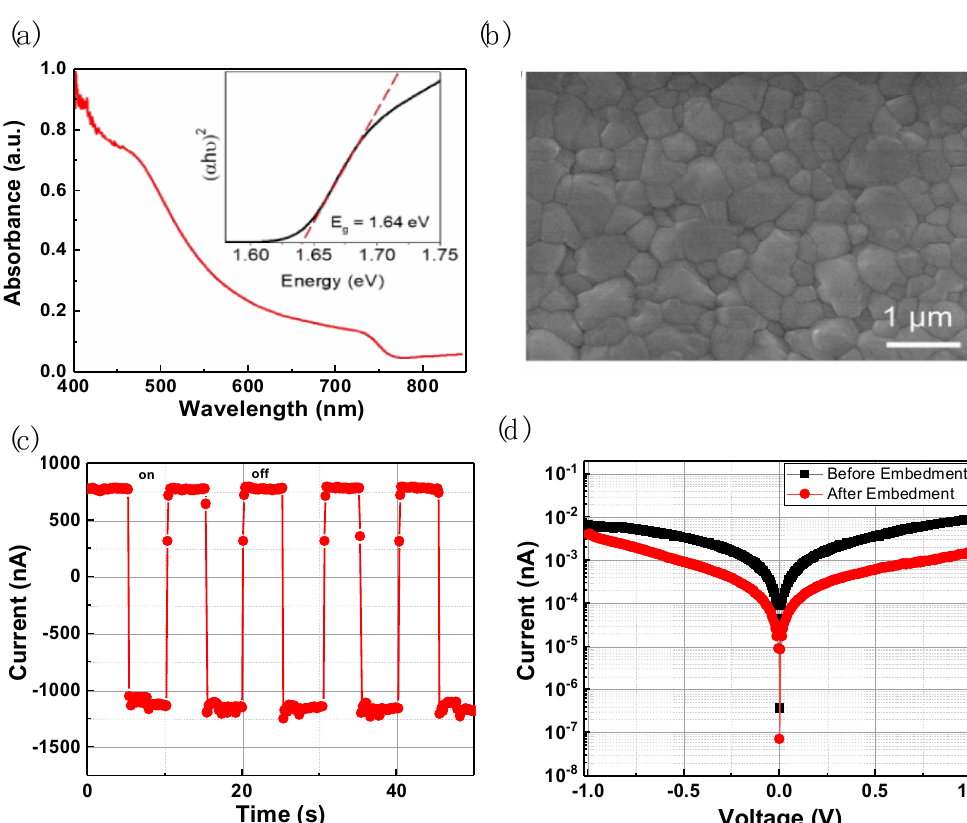
Figure 6. ( a ) UV-vis absorption spectrum [17]. ( b ) SEM image of the MAPb(Br 0.1 I 0.9 ) 3 perovskite film [17]. ( c ) On-off cycles of the perovskite photodetector under white light. ( d ) I-V characteristics of the devices in the dark.